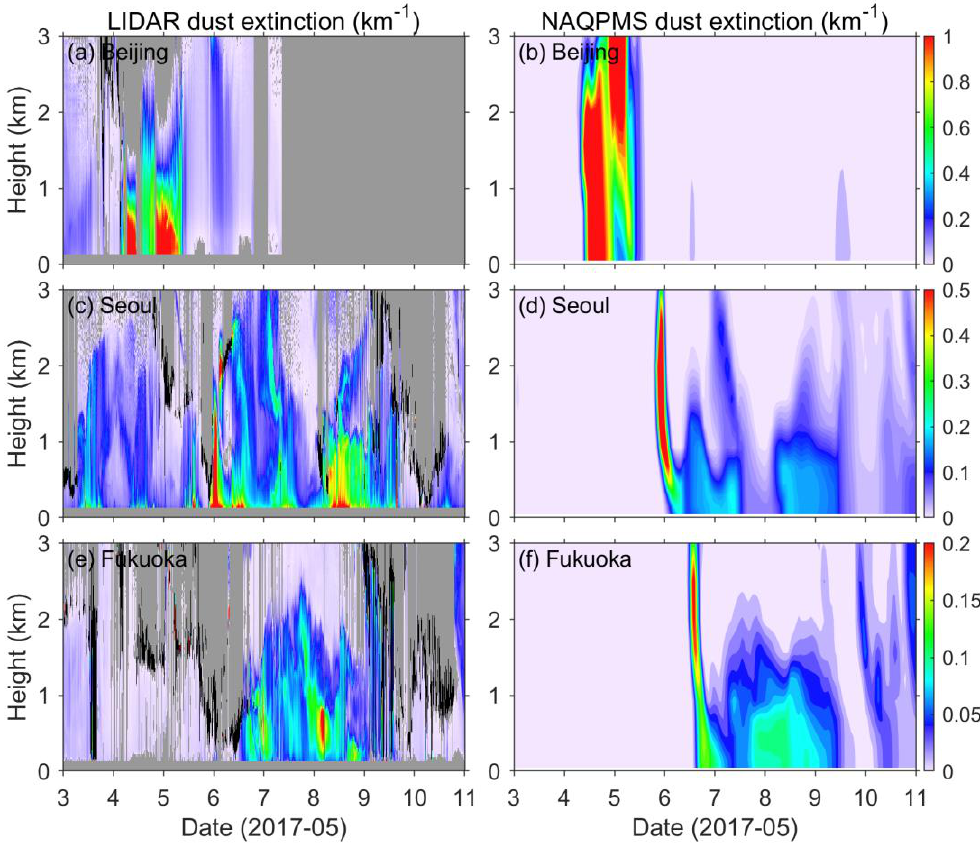
Figure 6. LIDAR-observed ( a , c , e ) and model-simulated ( b , d , f ) vertical distributions of dust-extinction coefficients in Beijing (a,b), Seoul (c,d), and Fukuoka (e,f). Black represents cloud, and gray coe ffi cients in Beijing ( a , b ), Seoul ( c , d ), and Fukuoka ( e , f ). Black represents cloud, and gray represents represents no data in the LIDAR observation figures. no data in the LIDAR observation